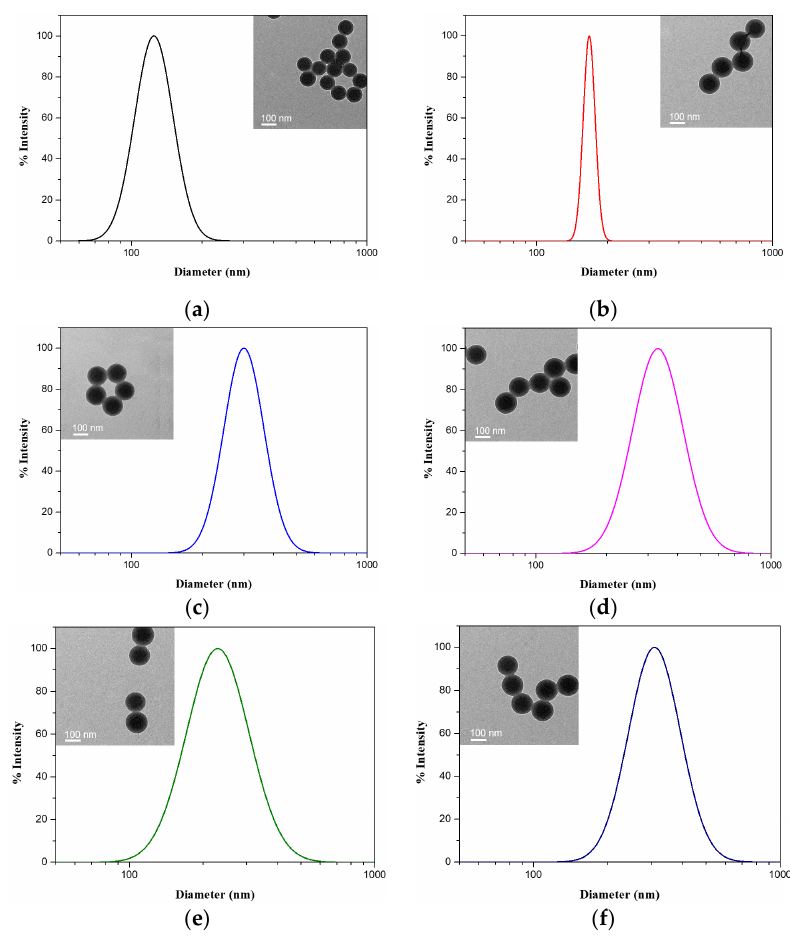
Figure 1. Size distributions and TEM images (insets) of polymer brushes. ( a ) polystyrene (PS) seed (black), ( b ) polystyrene with photoiniferter (PSV) (red), ( c ) PAA-grafted PSV emulsion (PSV@PAA) (blue), ( d ) poly(acrylic acid)-b-poly(N-(2-hydroxyethyl) acrylamide (PSV@PAA-b-PHEAA) (magenta), ( e ) PHEAA-grafted PSV emulsion (PSV@PHEAA) (olive) and ( f ) poly(N-(2-hydroxyethyl) acrylamide)-b-poly(acrylic acid (PSV@PHEAA-b-PAA)